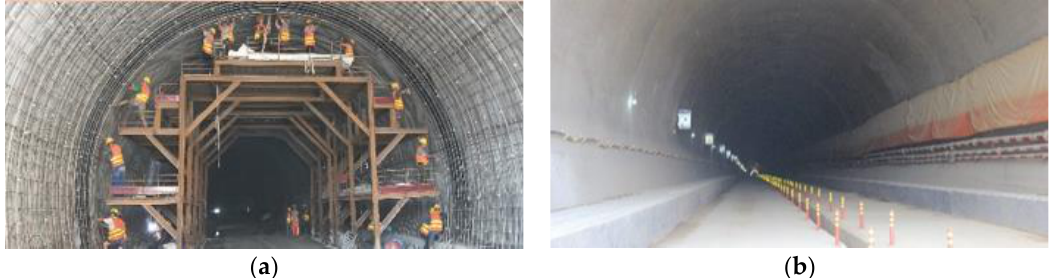
Figure 10. Monitoring curves of tunnel deformation after support optimization.